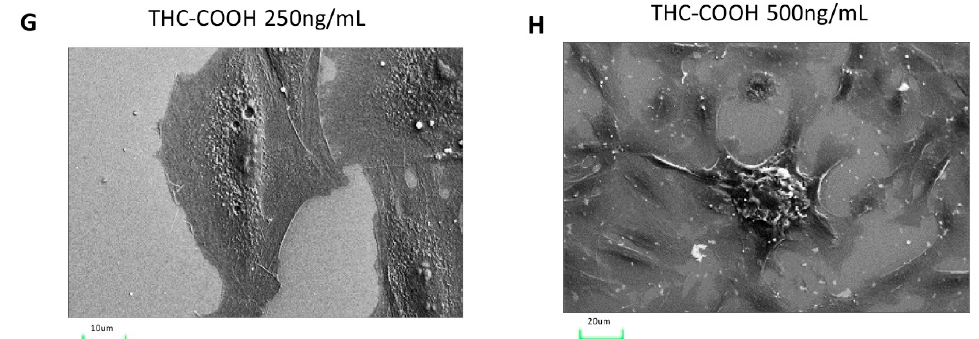
Figure 5. Dose dependent cannabinoid treatments result in morphological alterations of H9c2 cardiomyocytes. ( A – D ) In response to both low dose and high dose THC treatments, 100–200 ng/mL, normal H9c2 cardiomyocytes morphology was retained with intercellular connections and spindle-like spreading present at 24 h following culture. ( E – H ) Morphological alterations induced in H9c2 cardiomyocytes following exposure to 250 ng/mL THC-OH or THC-COOH. H9c2 cardiomyocytes indicated features of altered microstructural architecture, with membrane polarization, cell-substrate adhesion and retraction observed posterior to sites of membrane folding. Scale bar for each panel are presented below the respective image with numerical assignment indicating feature specific responses.